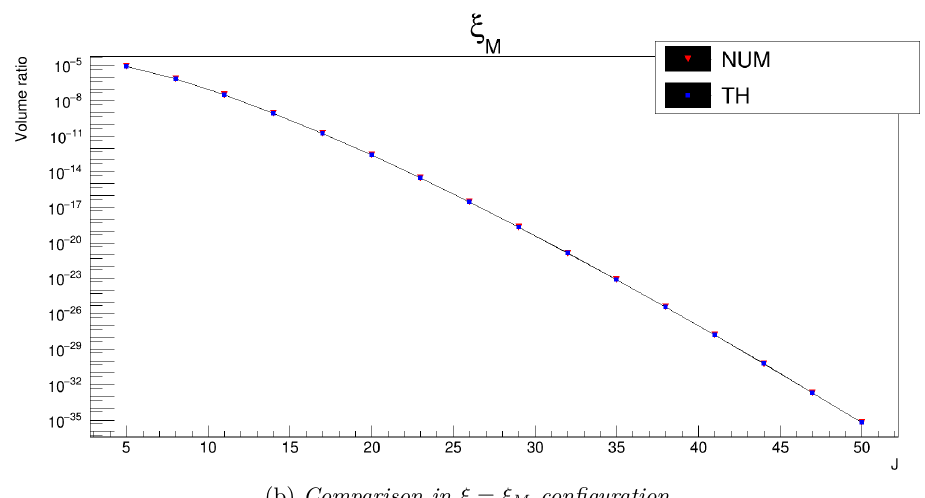
Figure 4 . Comparison between numerical and analytical results for ξ = ξ min (top) ξ = ξ M (bottom). Red points denote the numerical results while the blue ones denote the theoretical results. The graphs are essentially overlapped showing a good agreement between the theoretical and numerical